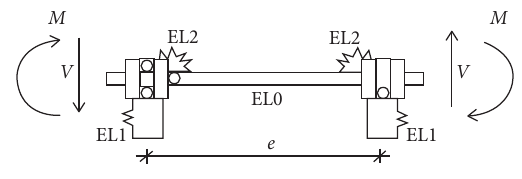
Figure 3: Modelling of the link Table 1: Characteristics of near-fault earthquakes used in the study. Record no.